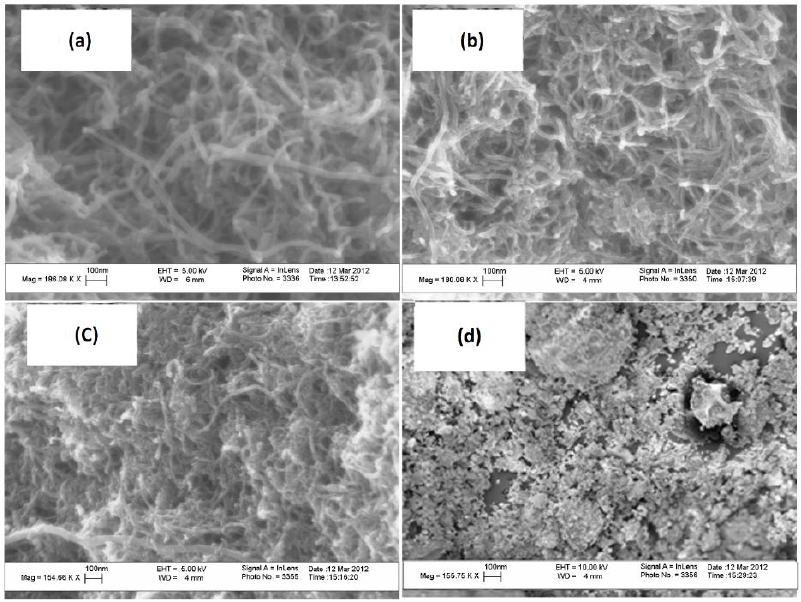
Figure 1. SEM images of ( a ) MWCNT-COOH, ( b ) p-MWCNT-Pd, ( c ) np-MWCNT-Pd, and ( d ) Pd/C.